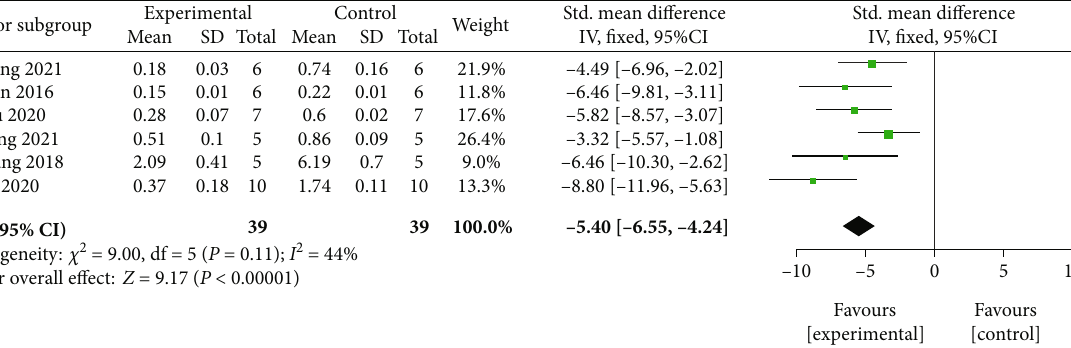
Figure 5: The forest plot: e ff ects of MSCs-derived sEVs for decreasing the brain water content compared with control group. TotalMeanExperimental Control Std. mean difference Study or subgroup Weight Mean SD Total SD IV, fixed, 95%CI